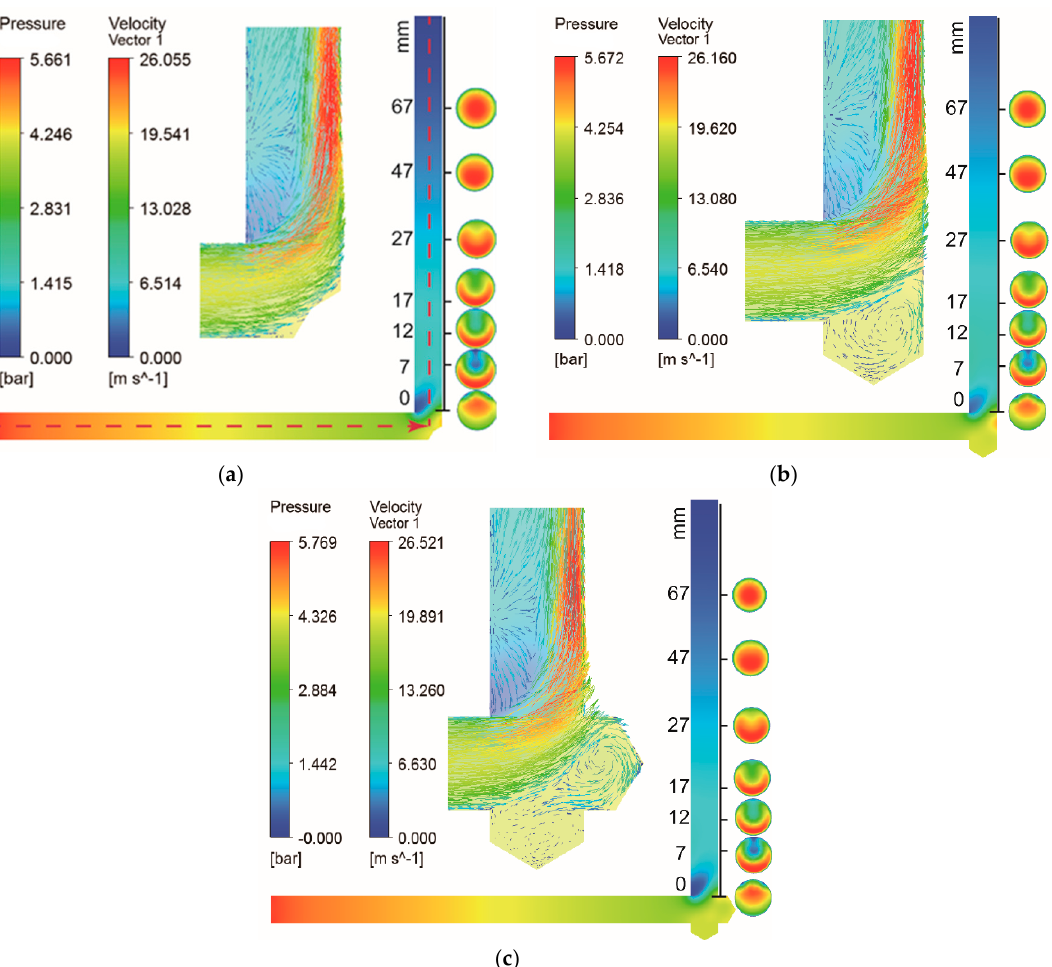
Figure 7. Pressure and velocity distribution in ( a ) I ‐ L, ( b ) I ‐ T, and ( c ) I ‐ X passage.